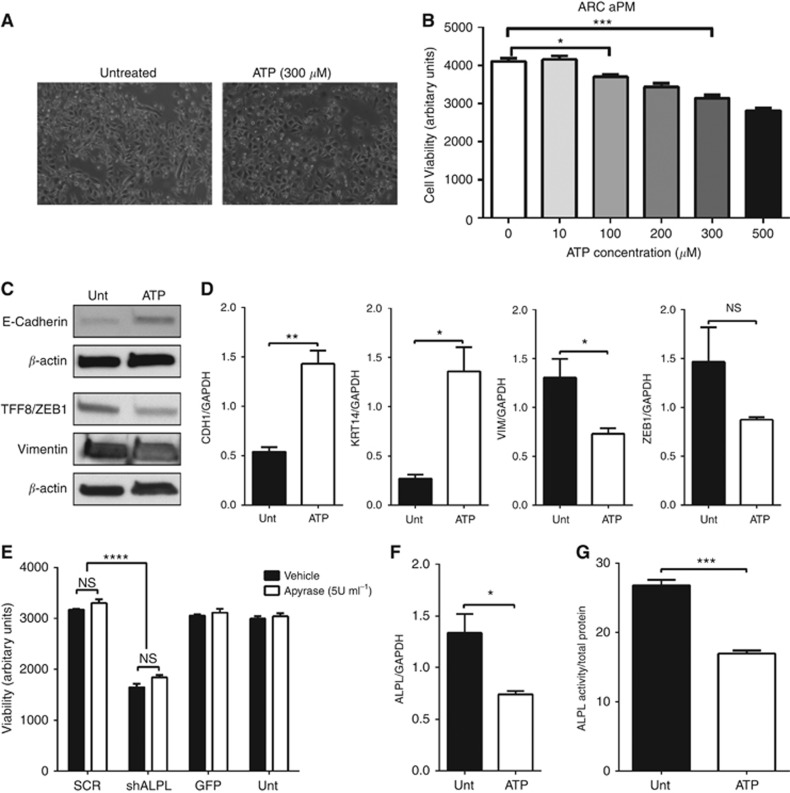
ATP induces MET and decreases viability, but does not mediate the effects of tumour-derived alkaline phosphatase. (A) ARCaPM cells were treated with exogenous ATP (300 μM) for 24 h and cell morphology was documented using phase-contrast microscopy. (B) Viability was measured using Alamar Blue assay in ARCaPM cells treated with increasing concentrations of ATP. (C) Protein levels and (D) mRNA expression of EMT markers were measured in ARCaPM cells treated with ATP (300 μM) for 24 h, using western blotting and qRT–PCR, respectively. (E) ARCaPM cells transduced with the indicated shRNA lentivirus were treated with vehicle or apyrase, and viability was measured using Alamar Blue assay. ALPL mRNA (F) and ALP activity (G) were measured in ARCaPM cells treated with ATP (300 μM) for 24 h, using qRT–PCR and a quantitative fluorimetric assay, respectively. (NSP>0.05, *P<0.05, **P<0.01, ***P<0.001, ****P<0.0001).